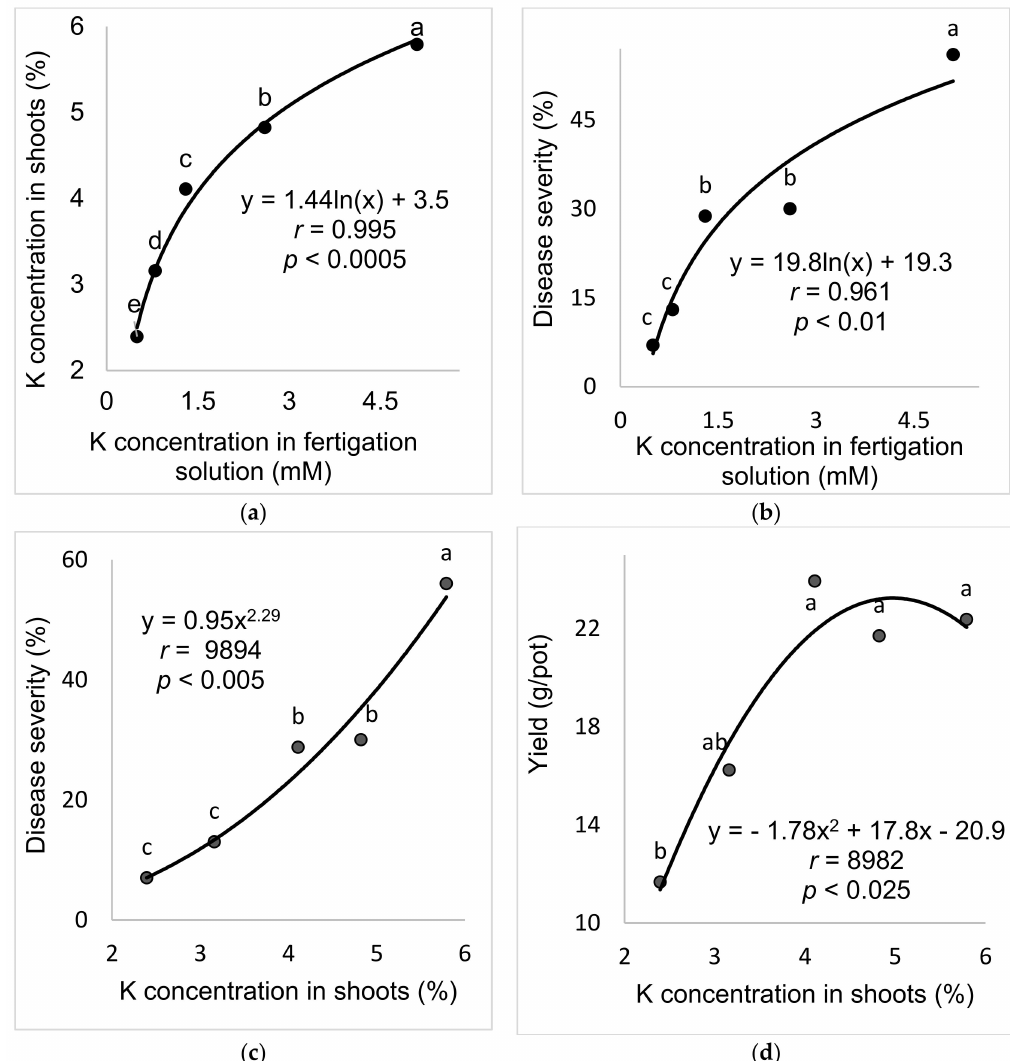
Figure 2. Effects of the K concentration in the fertigation solution on ( a ) the K concentration in the sweet basil shoots, ( b ) the severity of sweet basil downy mildew (SBDM) and ( d ) yield. SBDM is described in relation with the K concentration in ( b ) the fertigation solution and ( c ) the shoots. SBDM was evaluated on a 0–100% severity scale, in which 0 = healthy plants and 100% = plants completely covered by SBDM symptoms/signs. Data derive from 3 trials ( n = 10). In each graph, values for each K treatment followed by a common letter are significantly not different from each other according to Tukey–Kramer’s HSD test ( p ≤ 0.05). The correlation formulas and Pearson regression values ( r ) are presented along with significance levels ( P ). Bar =